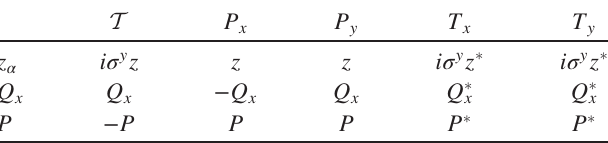
z (cid:2) (cid:4) ¼ i σ y z . x;y ½